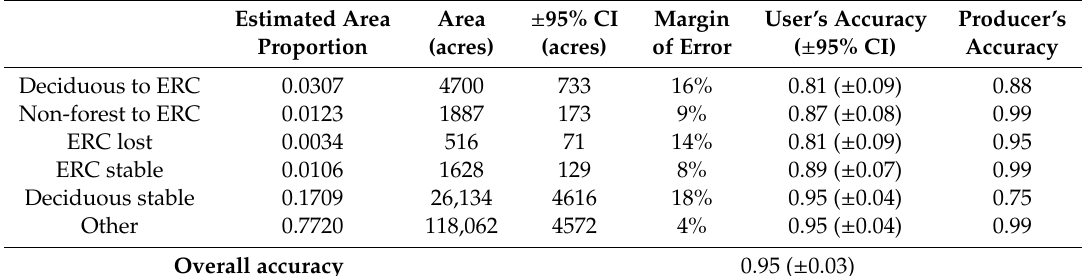
Table 5. Area estimation with 95% confidence intervals—Bourbon County